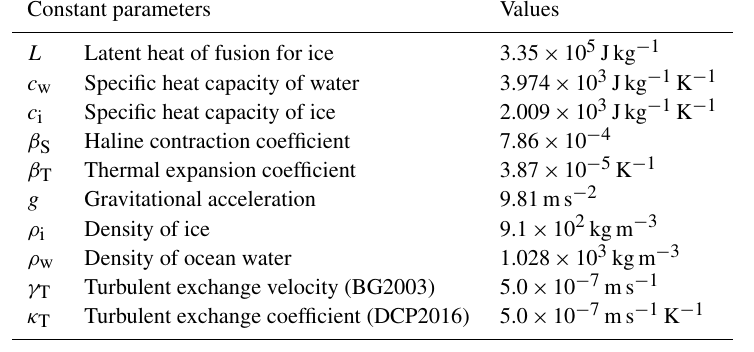
Table 3. Additional model parameters used for evaluating the plume model and the simple parametrizations described in Sect. 3.1. BG2003 refers to Beckmann and Goosse (2003) and DCP2016 refers to DeConto and Pollard (2016).